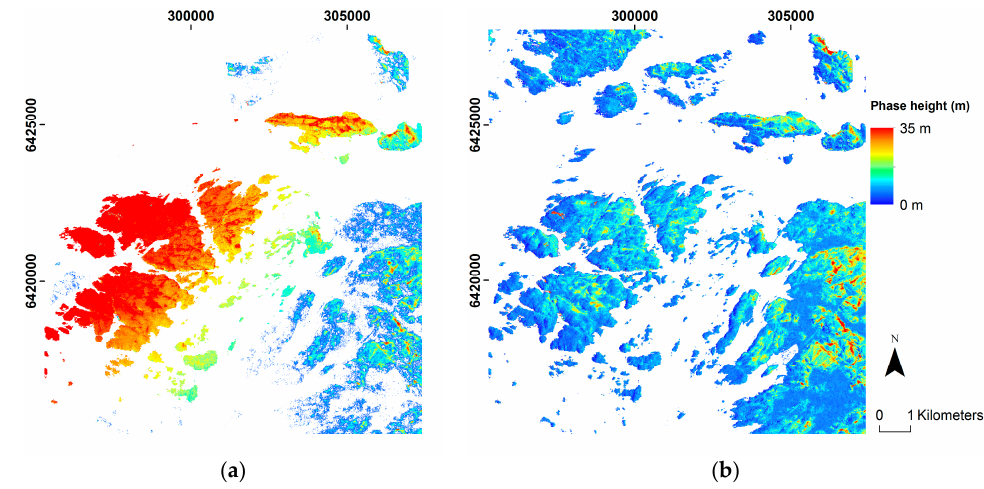
Figure 13. ( a ) Phase trends caused by incorrect trend corrections, caused by incorrect minimum cost flow phase unwrapping. Phase jumps between islands gave height differences of multiples times the HOA. ( b ) The same coastal region correctly unwrapped.